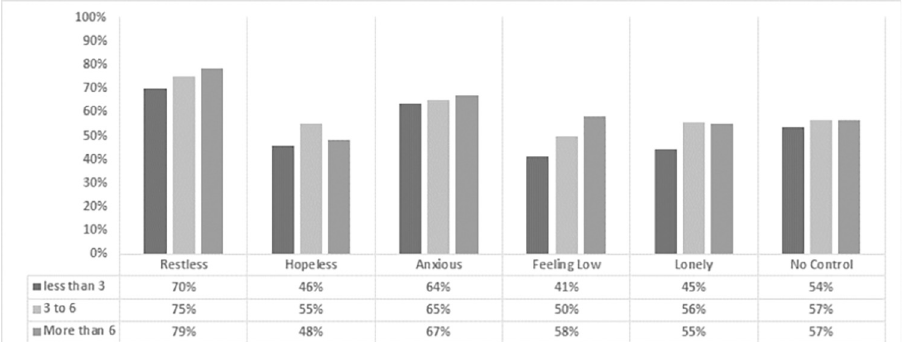
Fig 4. Number of working hours and types of mental health